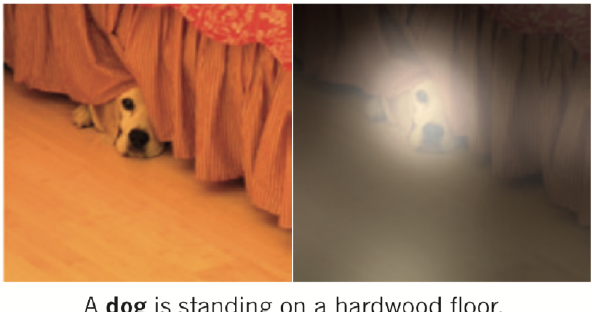
Figure 11. Deep Learning [88]: This method highlights the region of an image (dog) that is most important for the part “dog” of the not quite correct predicted output “A dog is standing on a hardwood floor” of a trained CNN. However, the dog is not